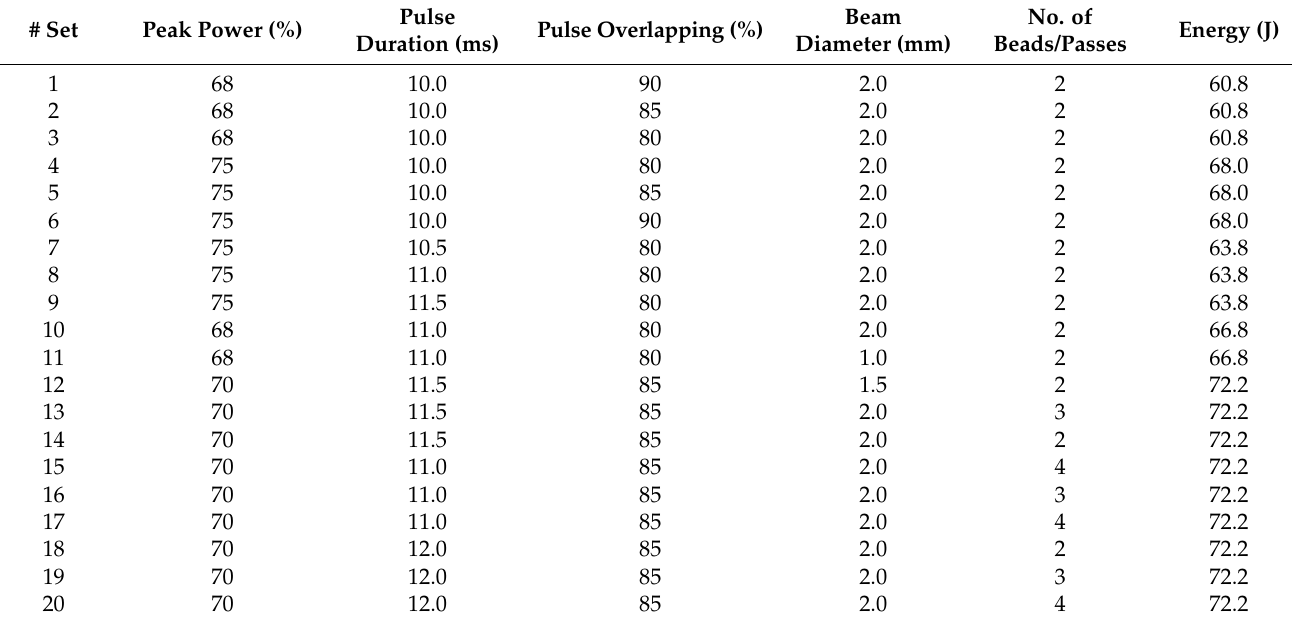
Table 3. Welding